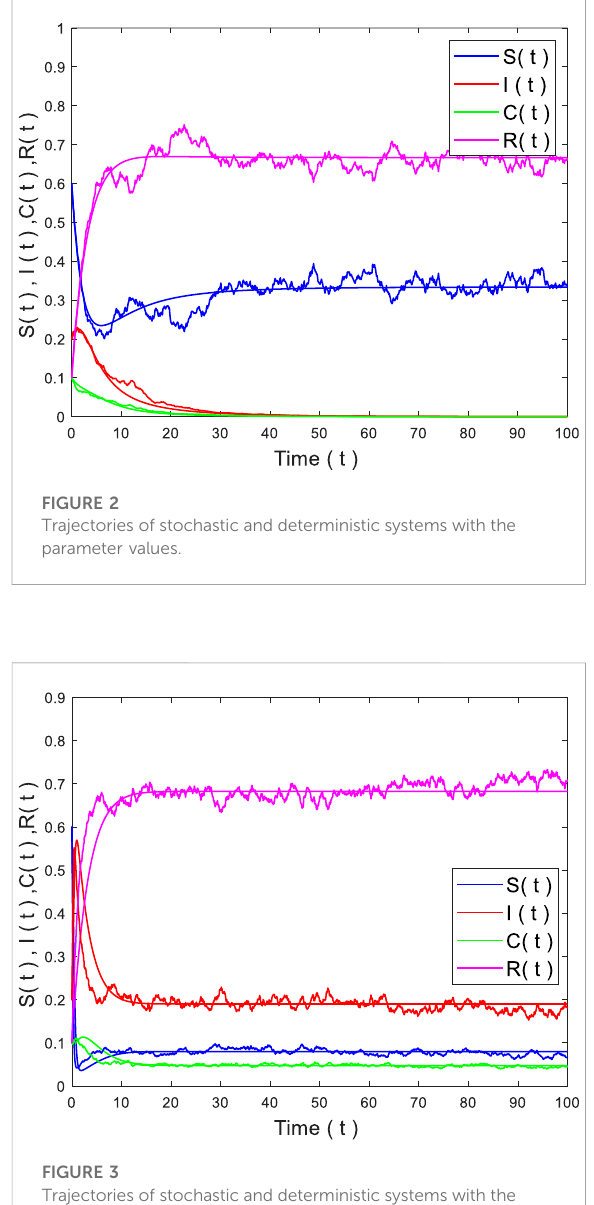
FIGURE 3 Trajectories of stochastic and deterministic systems with the parameter